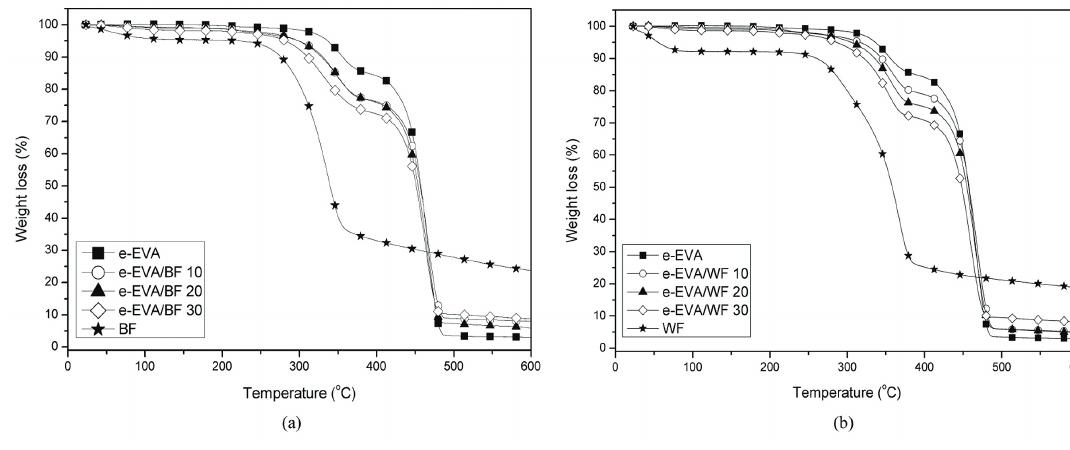
Figure 6. TGA and DTG of e-EVA compared to (a) e-EVA/BF and (b) e-EVA/WF.